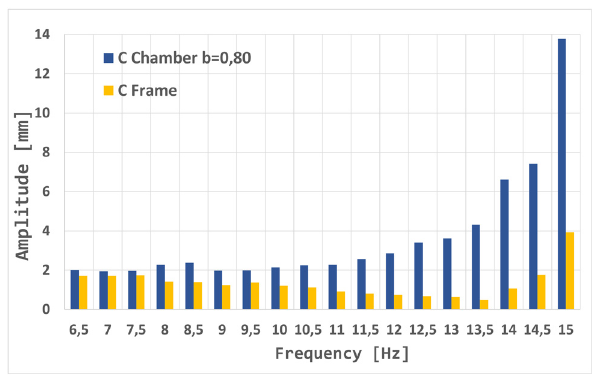
Figure 9: Amplitude – frequency characteristic of the antiresonance mill for the chamber fi lling degree equal to 0.80.